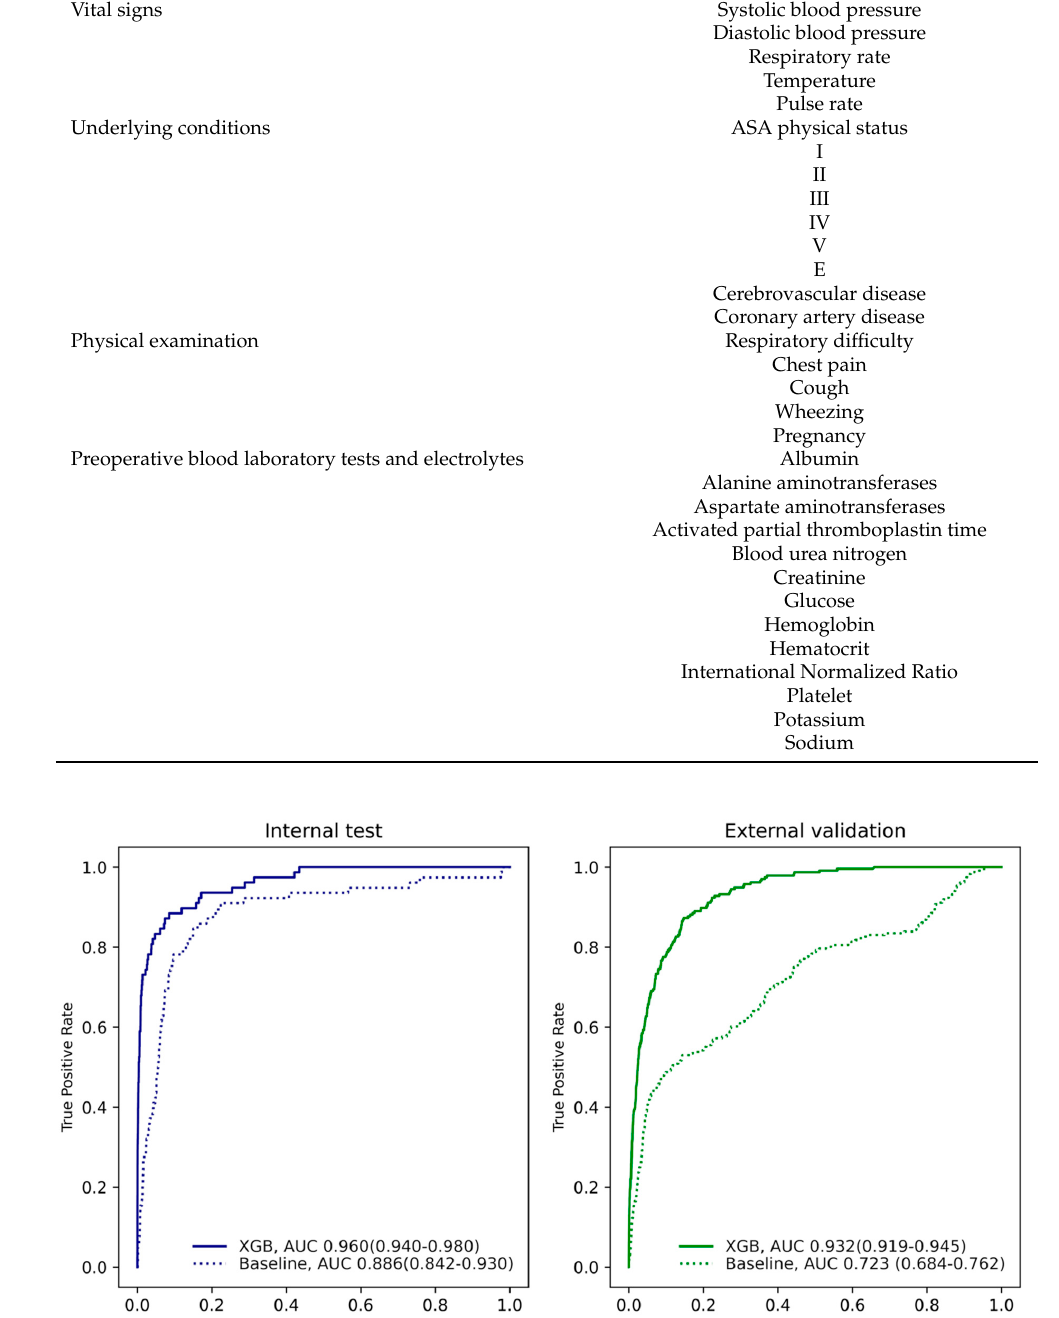
Figure 3. Calibration plot between model ‐ predicted probability and true probability. 3.3. Subanalyses Balanced datasets created from under ‐ sampling yielded a mean AUROC ≥ 0.932. The model performance of all down ‐ sampled datasets is described in Supplementary Figure S1. The model yielded an AUC ≥ 0.910 for all age groups and genders in subgroup anal ‐ yses. Patients >60 years had the worst model performance across all sexes and compared with all other age groups. Detailed model performance for all subgroups is described in Table 3.